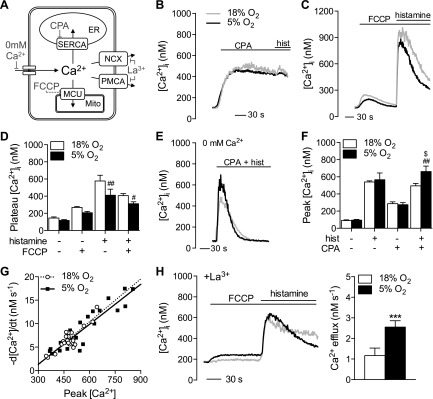
Ca2+ efflux pathways in ECs under 5% O2. HUVECs were cultured under standard (18%) or physiologic (5%) O2 levels, and changes in [Ca2+]i were determined using fura-2. A) Schematic illustration of the Ca2+ efflux mechanisms present in cells and their pharmacological inhibition. FCCP indirectly inhibits the MCU by collapsing the mitochondrial membrane potential. B) Effects of SERCA inhibition (10 µM, CPA) on [Ca2+]i. Histamine (10 µM, hist) was added 3 min after CPA to assess the degree of store depletion. C) Treatment with FCCP (5 µM) alone followed by histamine stimulation as before. D) Mean ± sem plateau [Ca2+]i from C. Treatment with CPA and/or histamine simultaneously (both 10 µM) in nominally free Ca2+ conditions to assess PMCA activity. E) Representative traces. F) Mean ± sem peak [Ca2+]i. G) Correlation between peak [Ca2+]i after treatment with histamine and CPA and the subsequent rate of decline in [Ca2+]i (a measure of PMCA activity). A positive correlation was confirmed by linear regression analysis, which also detected no significant difference between the 2 data sets. H) HUVECs were pretreated with La3+ (1 mM) and stimulated sequentially with FCCP (5 µM) and histamine. Representative traces and the mean rate of Ca2+ extrusion quantified by linear regression analysis of the slope are provided. Data denote or are representative of 4–5 different donors. #P < 0.05, ###P < 0.01 vs. 18% O2, ***P < 0.001 vs. 18% O2, $P < 0.05 vs. histamine alone.